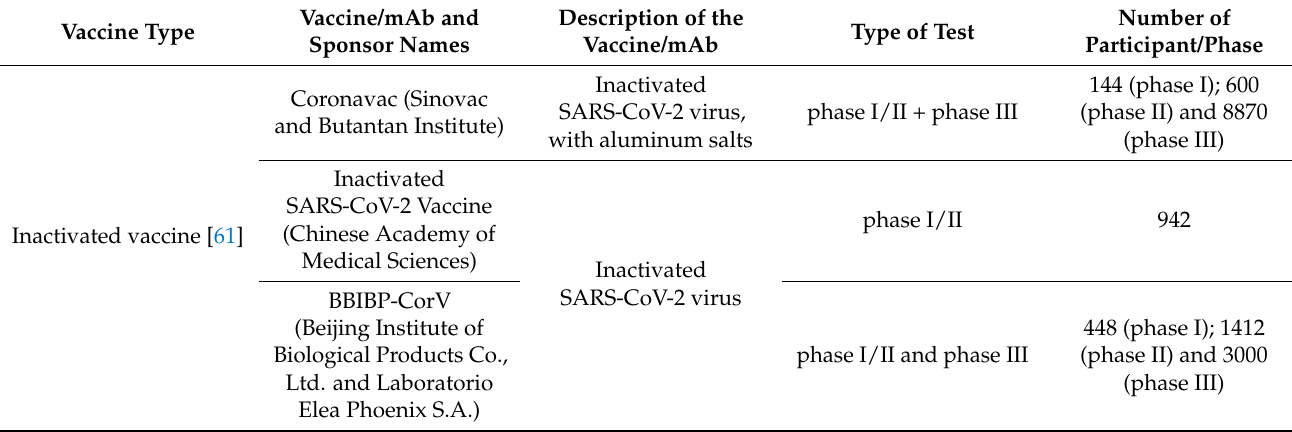
Table 2. Examples of SARS-CoV-2 vaccines (12 of 88 [60]) from the main types (from the 7 April 2021 infovac update) and two main monoclonal antibodies among those in clinical trials (from a 15 December 2020 review). Vaccine